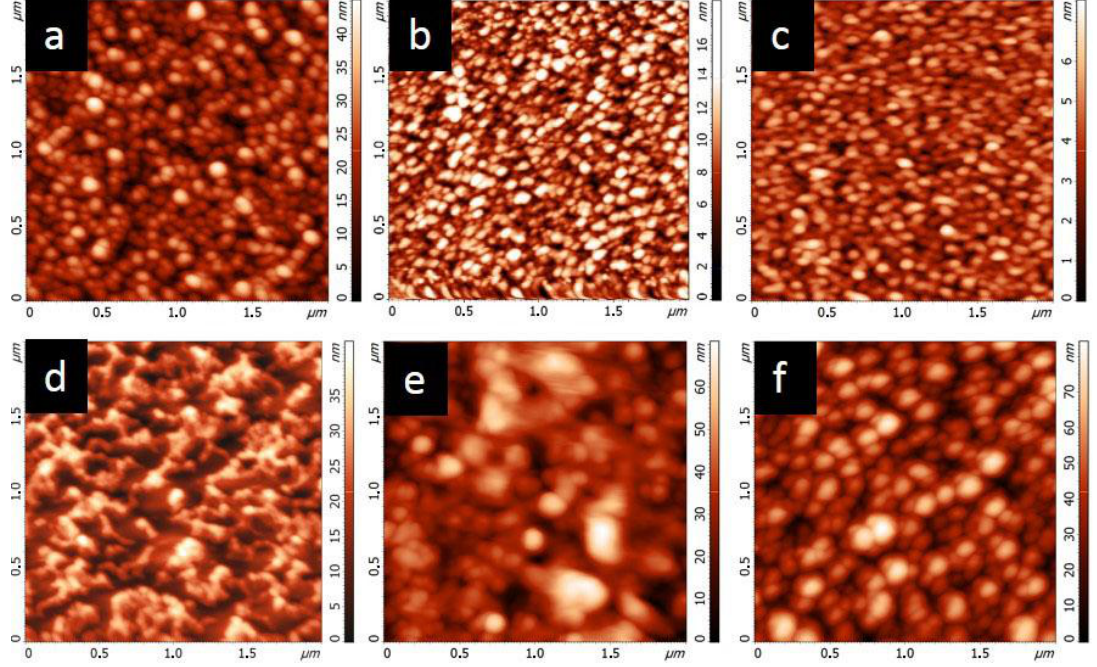
Figure 2. AFM images of Ti-Al-N films ( a ) 200 ◦ C, 20 sccm; ( b ) 200 ◦ C, 40 sccm; ( c ) 200 ◦ C, 60 sccm; ( d ) 500 ◦ C, 20 sccm; ( e ) 500 ◦ C, 40 sccm and ( f ) 500 ◦ C, 60 sccm. Table 3. Influence of temperature and nitrogen flow rate on morphological properties of the Ti-Al-N films. Temperature ( ◦ C) Nitrogen Flow Rate (sccm) Thickness (µm) RMS (nm)